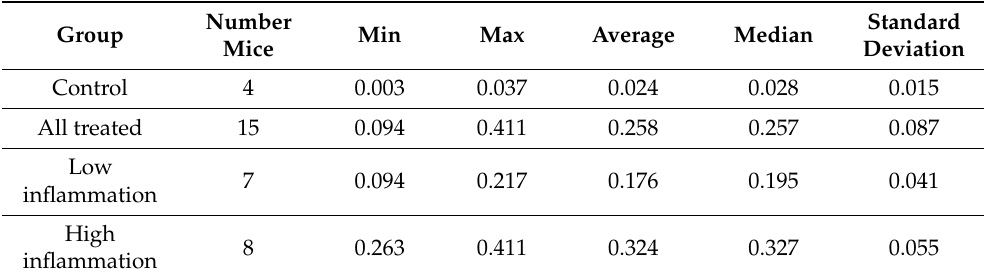
Figure 3. Immunohistochemistry analysis of CD45 cell infiltration in lung sections from control ( top right ) and treated with RT and ICI mice ( bottom right ). The box chart ( left ) demonstrates the quantitative analysis of CD45 distribution in the two cohorts. Table 1. Descriptive statistics on CD45 infiltration obtained from the lung tissues through immuno- histochemistry